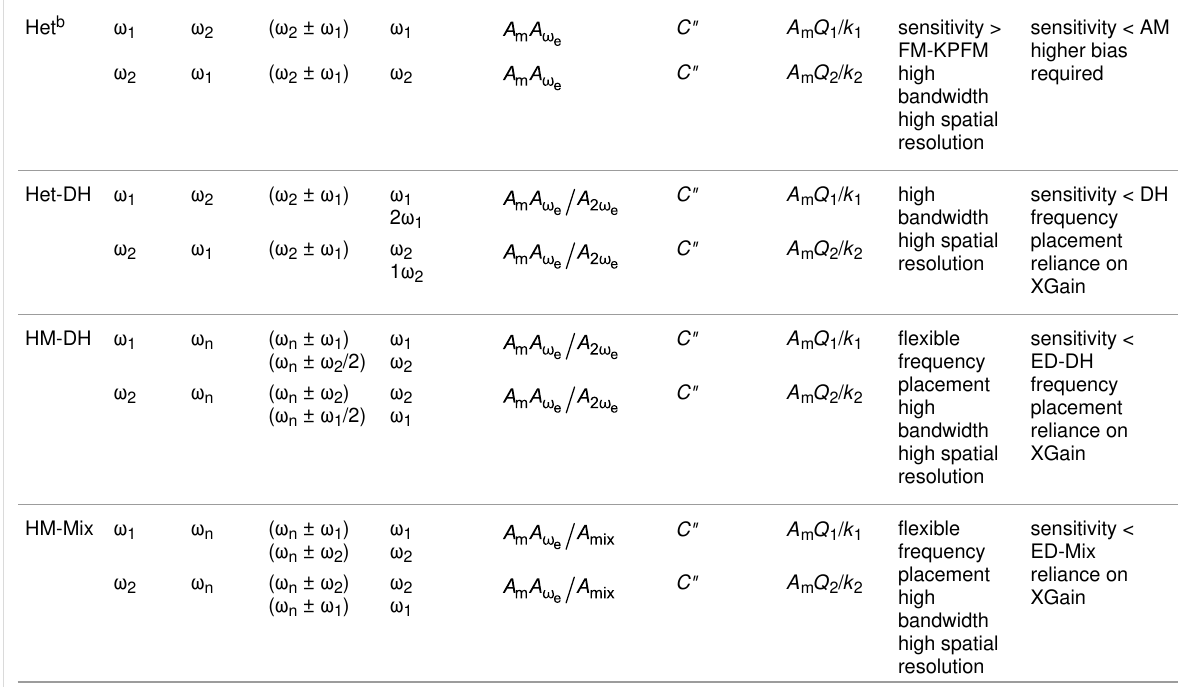
Table 3: Summary of drive and detection (Det.) schemes. a (continued) Het